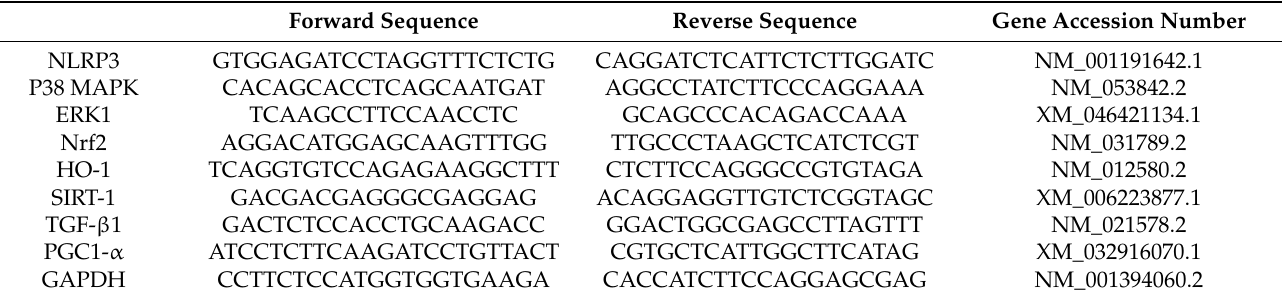
Table 2. Primer’s sequence of all studied